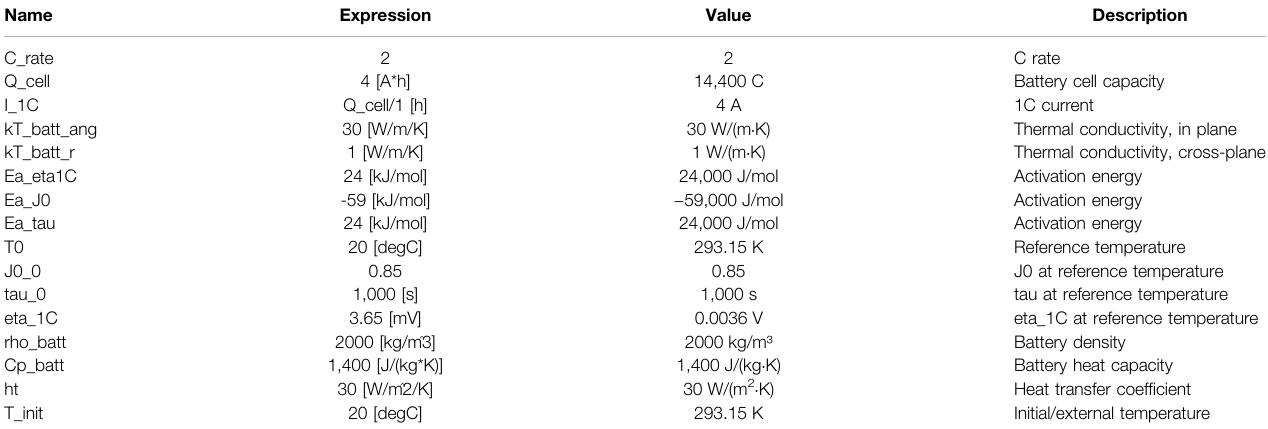
TABLE 3 | Geometrical and internal battery parameters of the simulated battery pack.